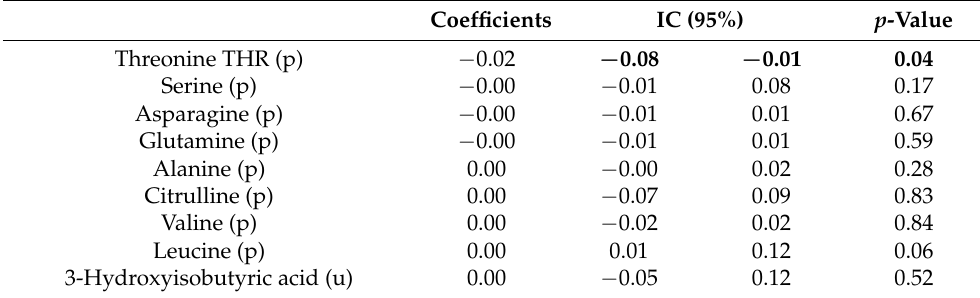
Table 4. Least absolute shrinkage and selection operator (LASSO) penalized regression analyses: important variables for EEG-based